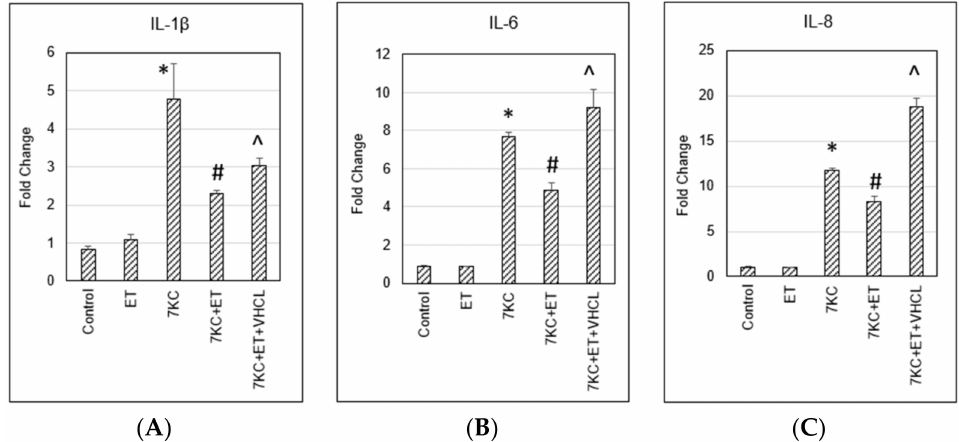
Figure 8. Inflammatory gene expression. 7KC induced increases in ( A ) IL-1 β , ( B ) IL-6 and ( C ) 1L-8 and mRNA expression, and these increases were significantly reduced by ET. ET: 1 mM ET; VHCL: 100 µ M VHCL; 7KC: 30 µ M 7KC. Data are represented as the mean ± SD (n = 4). * Significant difference compared to controls ( p < 0.05). # Significant difference compared to 7KC. ˆ Significant difference compared to ET + 7KC. Data were analysed by one-way ANOVA with Bonferroni’s multiple comparison post-hoc